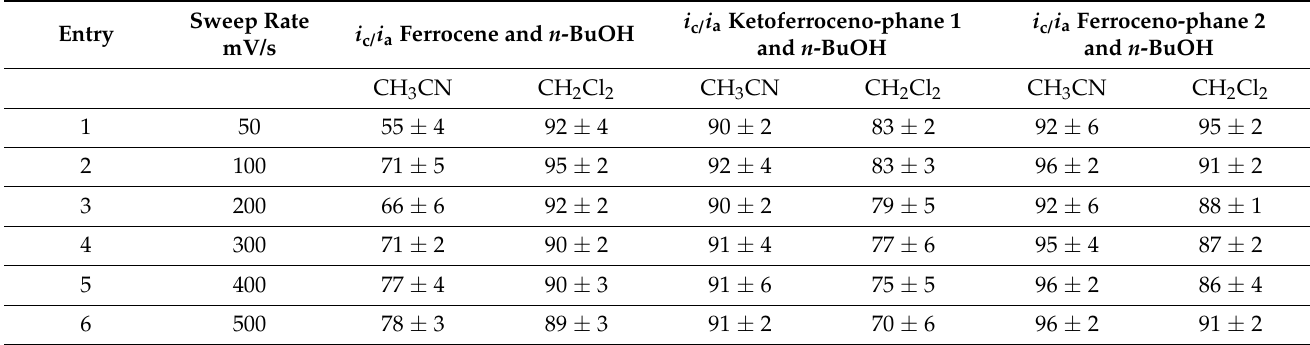
Table 4. i c / i a values at different sweep rates in the presence of n